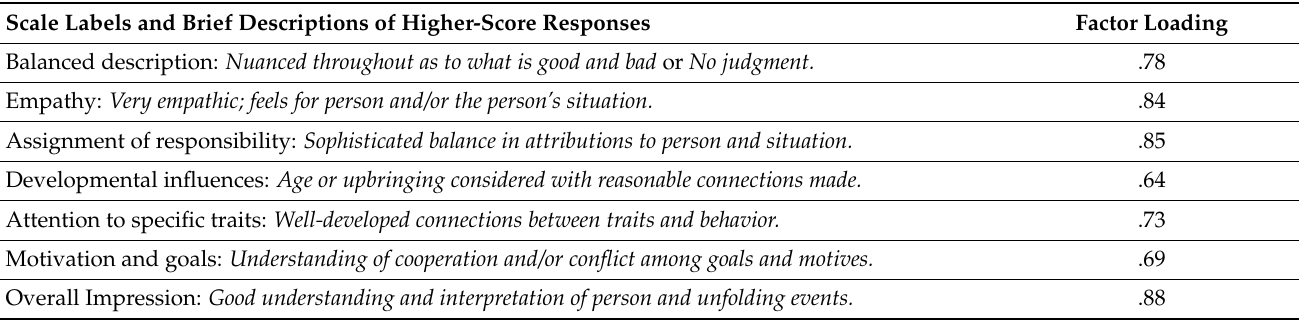
Table 1. The Six Rating Scales for Sophistication and their Factor Loadings on the One-Factor Model a .